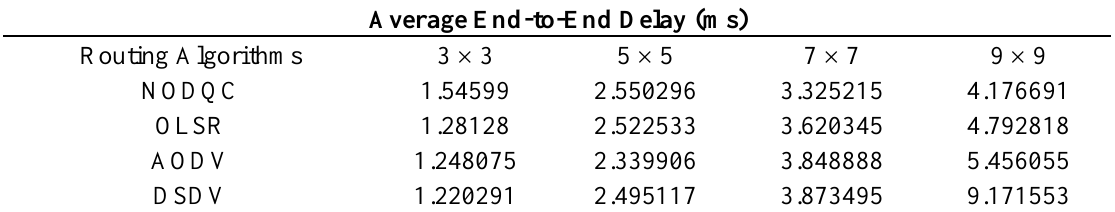
Table 10. Experiment results of routing algorithms (average end-to-end delay).